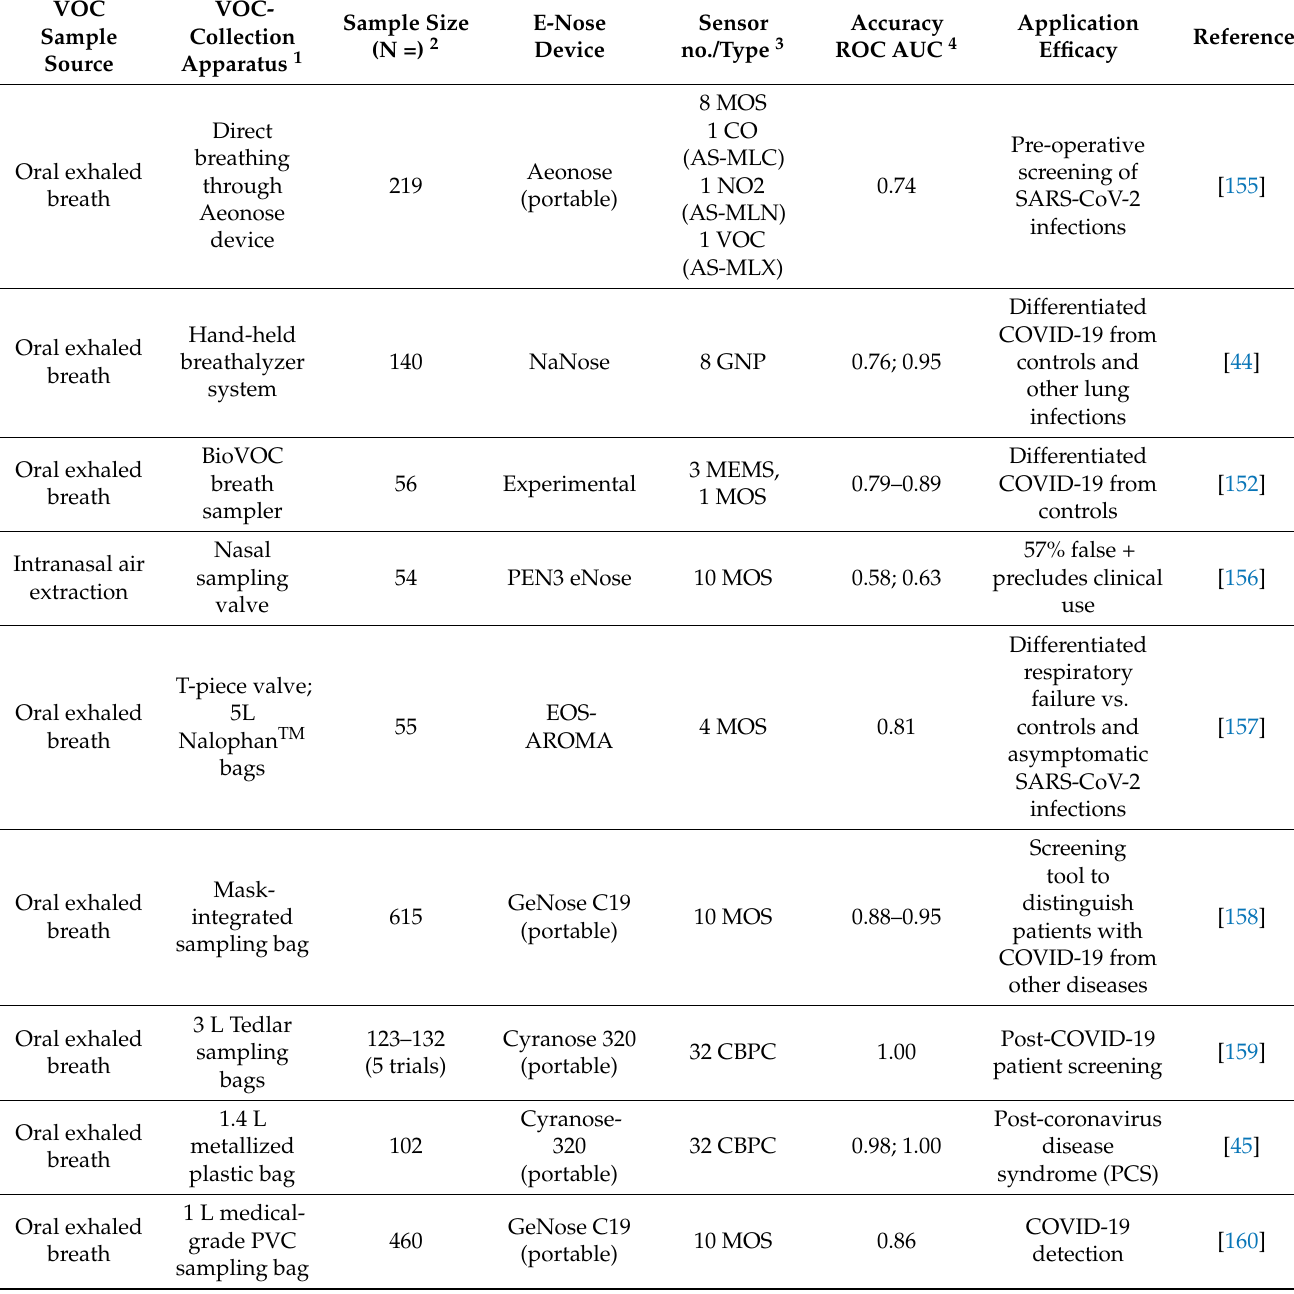
Table 3. Experimental electronic-nose systems tested for COVID-19 detection with performance and efficacy